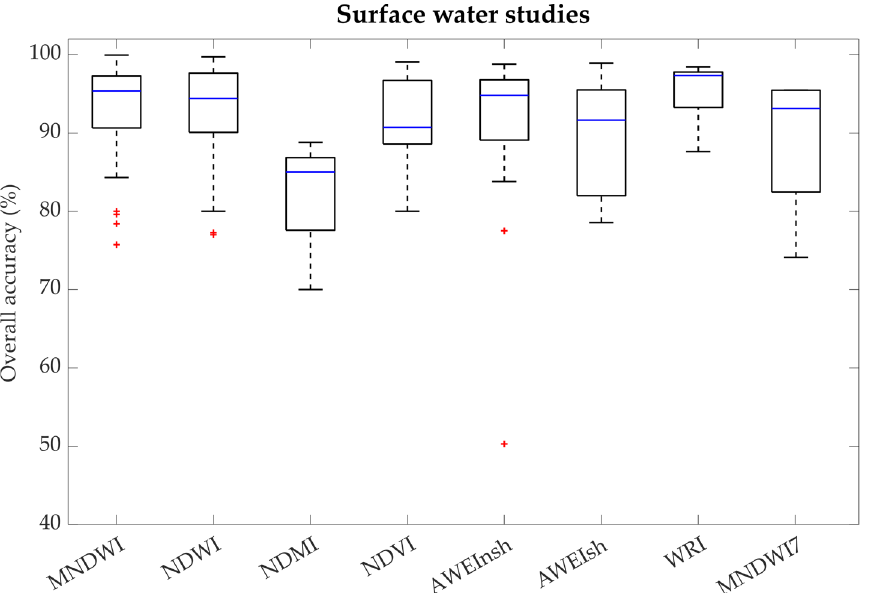
Figure 4. Results of the performances of spectral indices in detecting land surface water, expressed in terms of overall accuracy (OA). The blue line represents the median value of the OA of each index, while red crosses represent outliers.